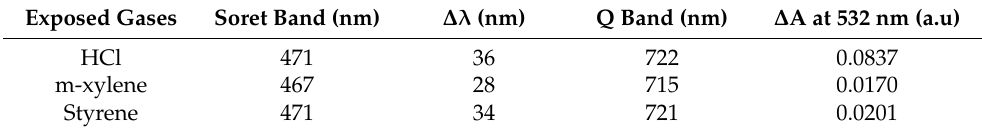
Table 3. Absorbance spectrum analysis of the PPc film with different gas exposures (1000 ppm). Exposed